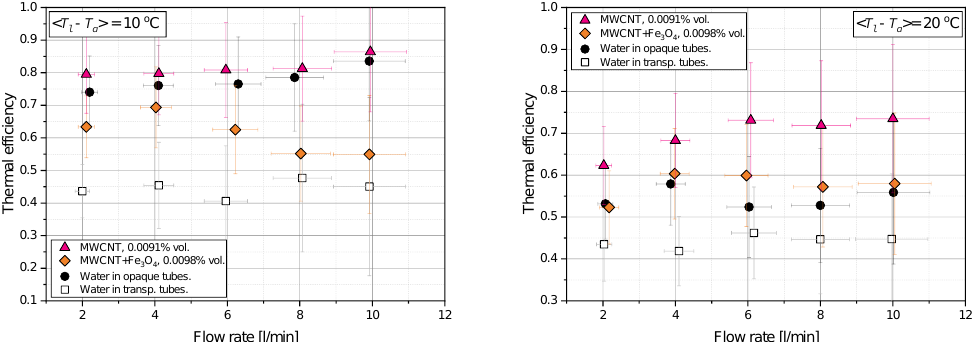
Figure 4. Efficiency of the tubular DASC for different flow rates, heat transfer fluids, and optical boundaries. The experiments are presented for Re = 2100 ∼